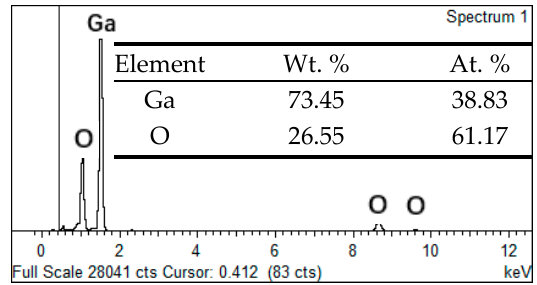
Figure 1. Morphology of Ga 2 O 3 particles: ( a ) 10,000 times; ( b ) 20,000 times.